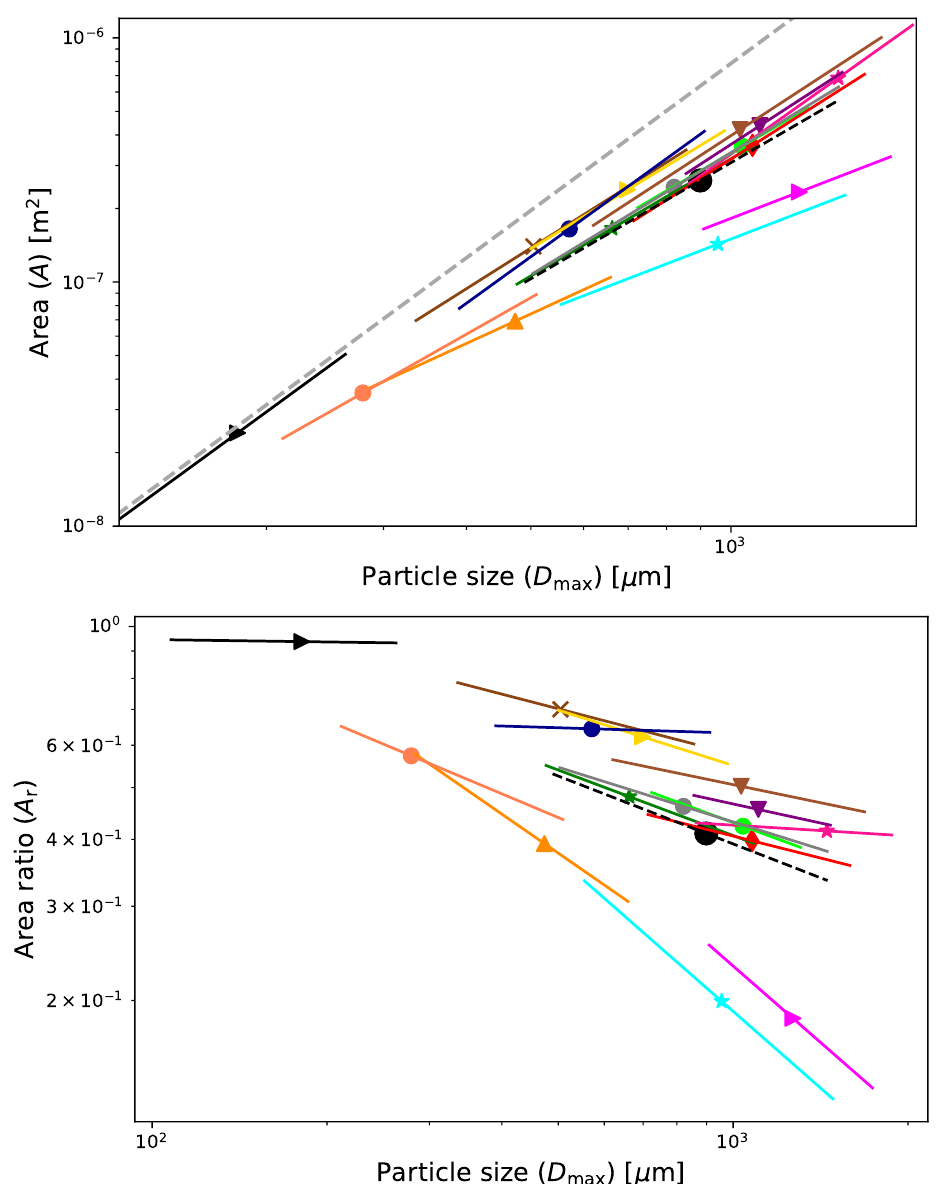
Figure 5. Area versus particle size ( A vs. D max ) and area ratio versus particle size ( A r vs. D max ) relationships for each shape group (solid lines) and for all data regardless of shape (black dashed lines) are shown. For a legend, see Figure 4. Fits of A versus D max and A r versus D max relationships are shown in logarithmic scale. The median D max of the data is represented as a single point on each line. The length of the fit lines are defined by percentiles 15.9% and 84.1% of D max . Top: A vs. D max relationship given by Equation (3). For comparison, the area of spheres given by ( π /4 ) as a gray dashed line. Bottom: A r vs. D max relationship given by Equation (4). The corresponding data are shown in Table 9.